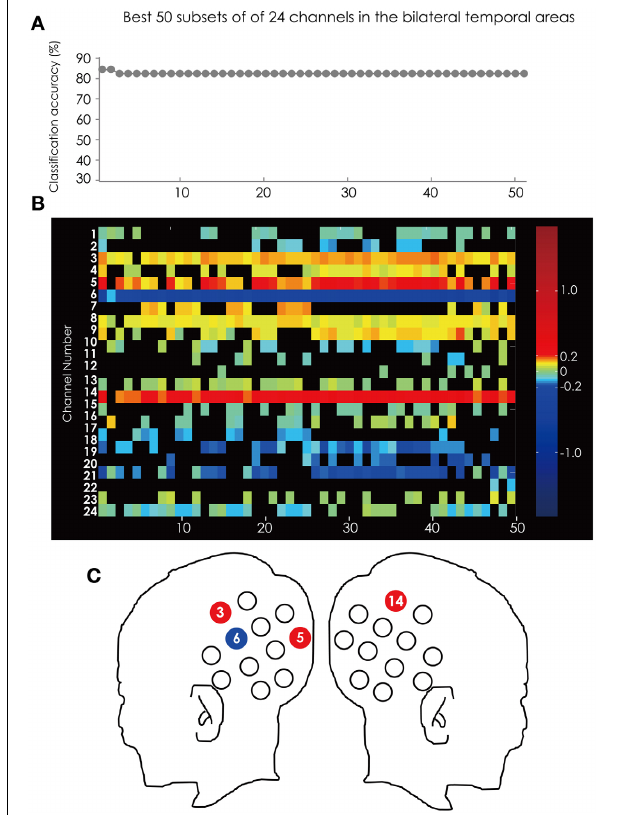
FIGURE 7 | (A) The classification accuracy corresponding with the best 50 subsets consisted from the channels in the bilateral hemisphere. (B) The channel numbers in the subsets represented in (A) . (C) The position of the channels referred to in the